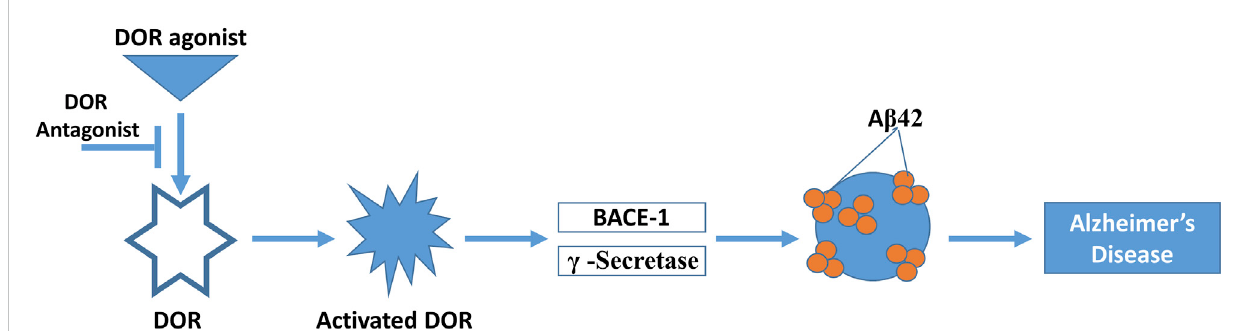
FIGURE 2 Interaction of the DOR with Alzheimer ’ s pathology. DOR is activated by DOR agonist, which in turn activates BACE1 and γ -secretase activity. This produces A β 42 protein aggregates, producing at least in part Alzheimer ’ s disease pathology. This process can be reversed by DOR antagonist